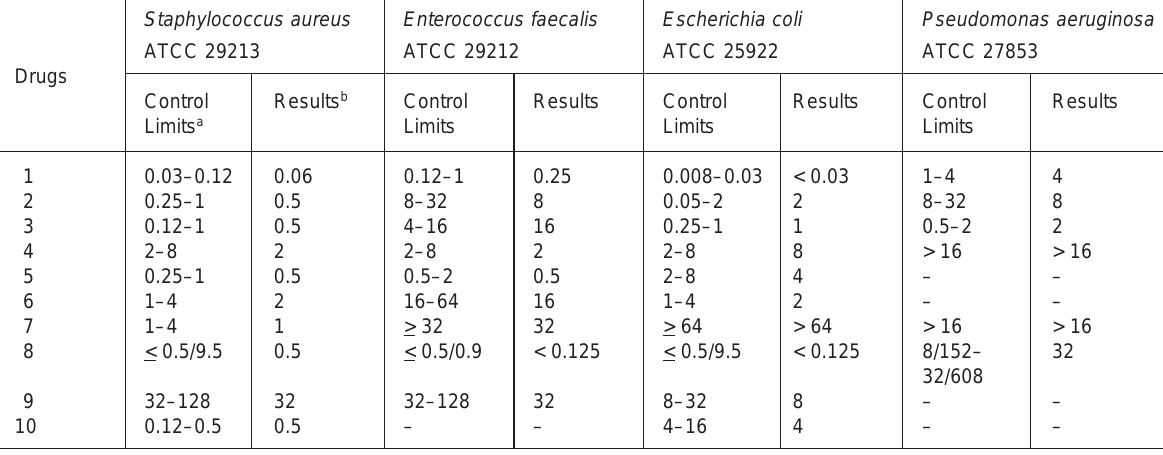
TABLE 3 Minimum inhibitory concentrations of reference strains tested after plates were stored frozen for 2